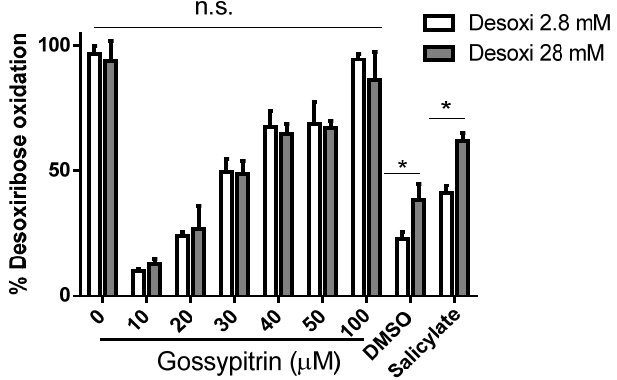
Figure 8. Effect of Gos and •OH scavengers dimethyl sulfoxide (DMSO) and salicylate on oxidative damage to 2.8 or 28 mM 2-deoxyribose induced by Fe(III)–EDTA plus ascorbate. Solutions were incubated for 30 min at 37 °C and contained 10 mM phosphate buffer (pH 7.2), 2-deoxyribose (2.8 or 28 mM), 150 µM EDTA, and 50 µM Fe(III). Reactions were started by the addition of ascorbate to a final concentration of 2 mM. The bars show means ± S.D. ( n = 3). Controls contain only DMSO (0.001%), which is the solvent concentration in Gos samples. The one-tailed t -test was used for statistical analyses; * p < 0.05, n.s.,